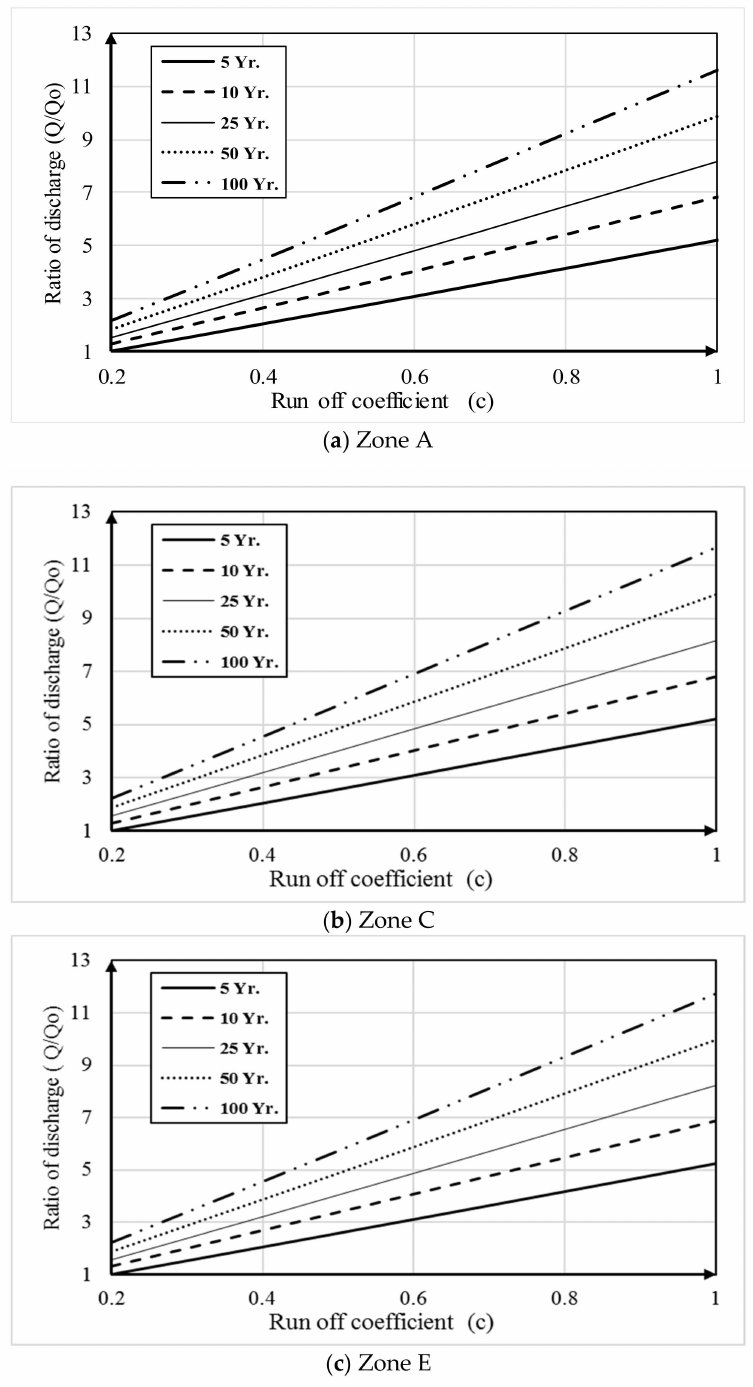
Figure 6. Relationship between runo ff coe ffi cient (C) and outlet discharges of zones A ( a ), C ( b ) and E ( c